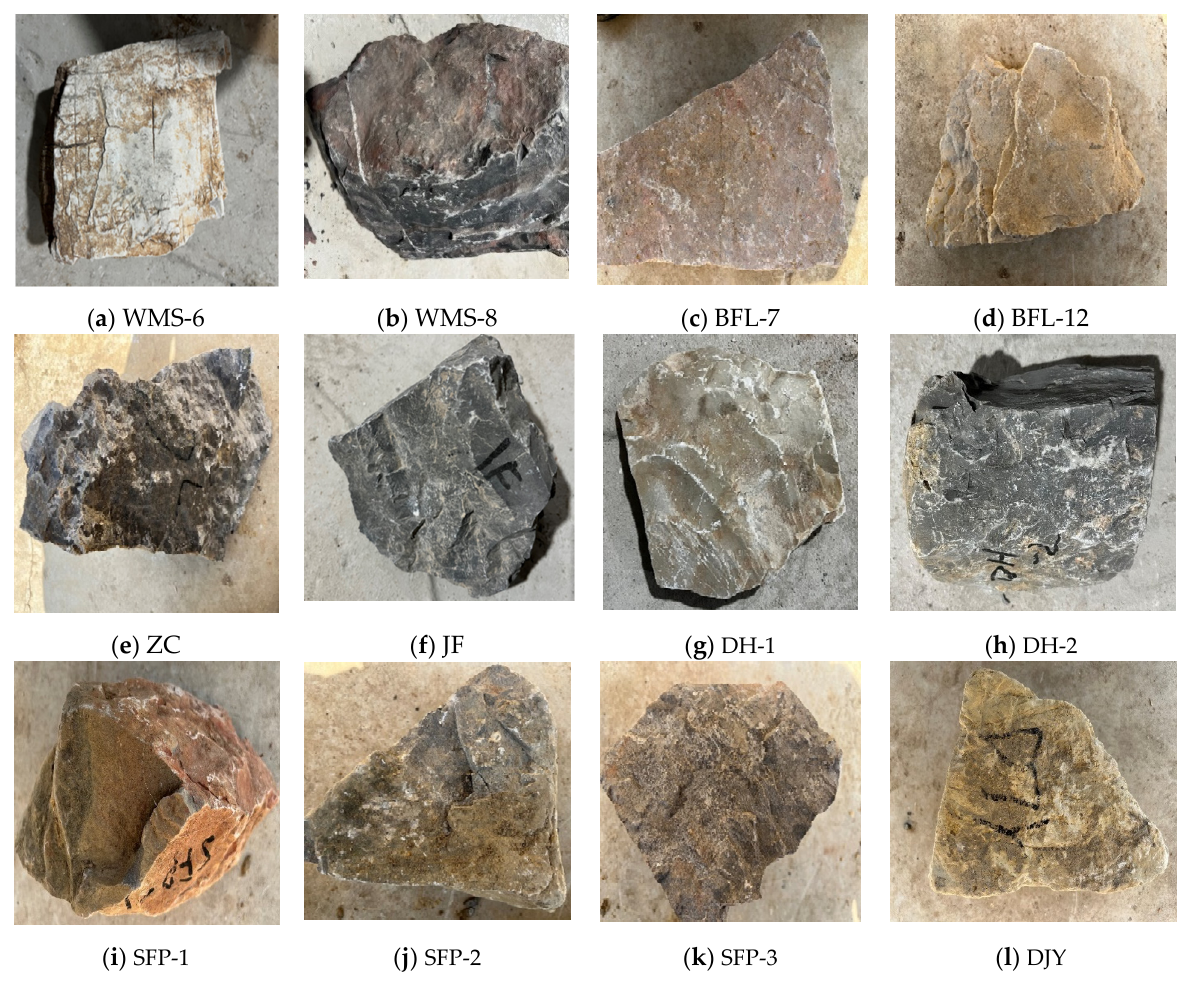
Figure 1. The appearance of dolostones. Table 1. Chemical composition of rocks.